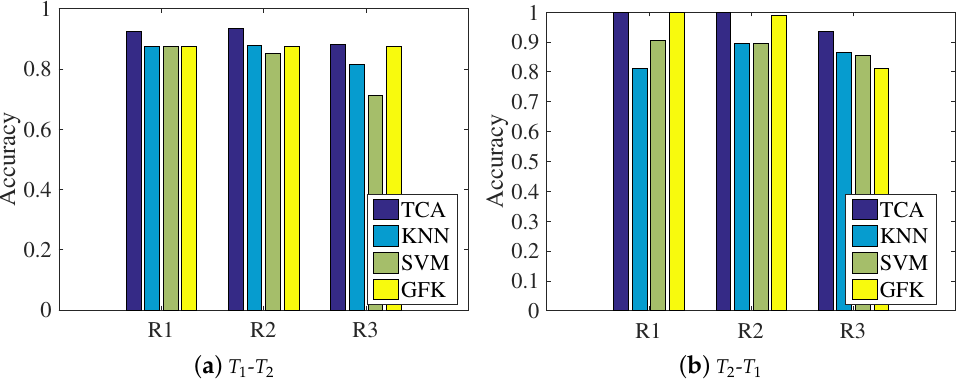
Figure 9. Chart of the comparison of classification accuracy among different representations: ( a ) train- ing with the T 1 dataset and testing on the T 2 dataset; ( b ) training with the T 2 dataset and testing on the T 1 dataset.